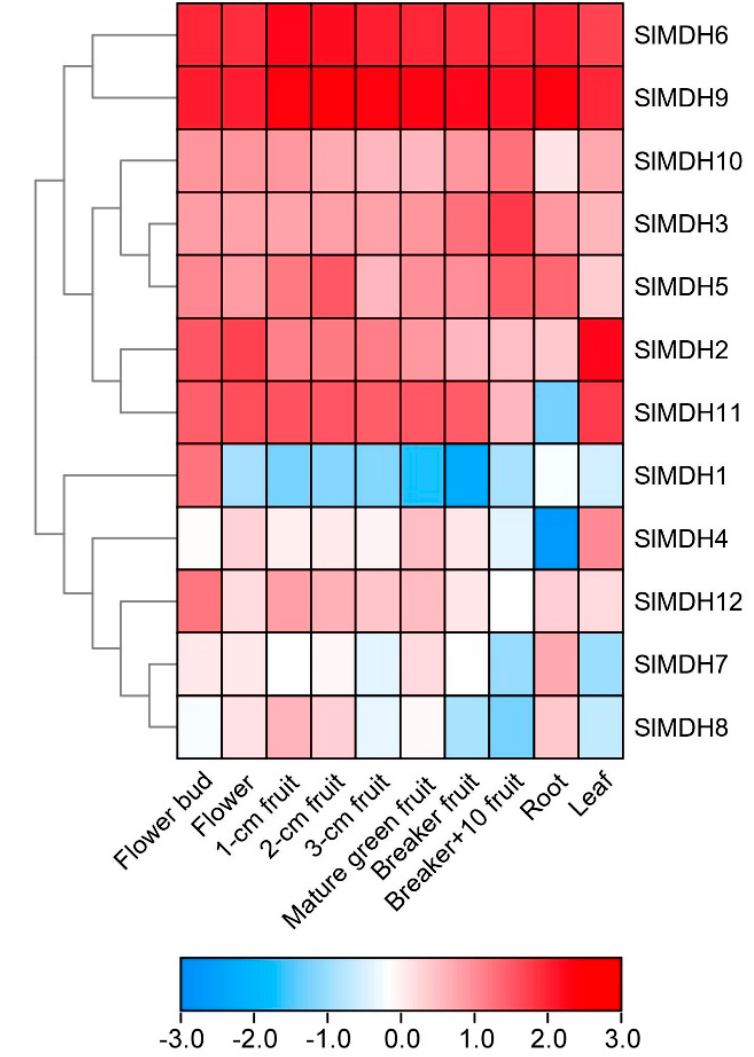
Figure 5. Expression analysis of tomato MDH genes in cultivated tomato cultivar Heinz 1706. Heatmap of RNA-seq data of Heinz. Flower bud, flower (fully opened flowers), 1 − cm fruit, 2 − cm fruit, 3 − cm fruit, mature green fruit, breaker fruit, fruit at 10 days after breaker stage (Breaker+10 fruit), root, and leaf. The expression values were calculated by Log 2 (FPKM) and presented accord- ing to the color code.